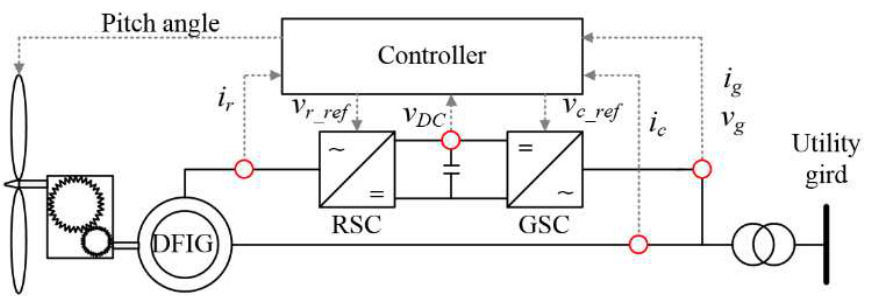
Figure 1. Typical DFIG configuration.